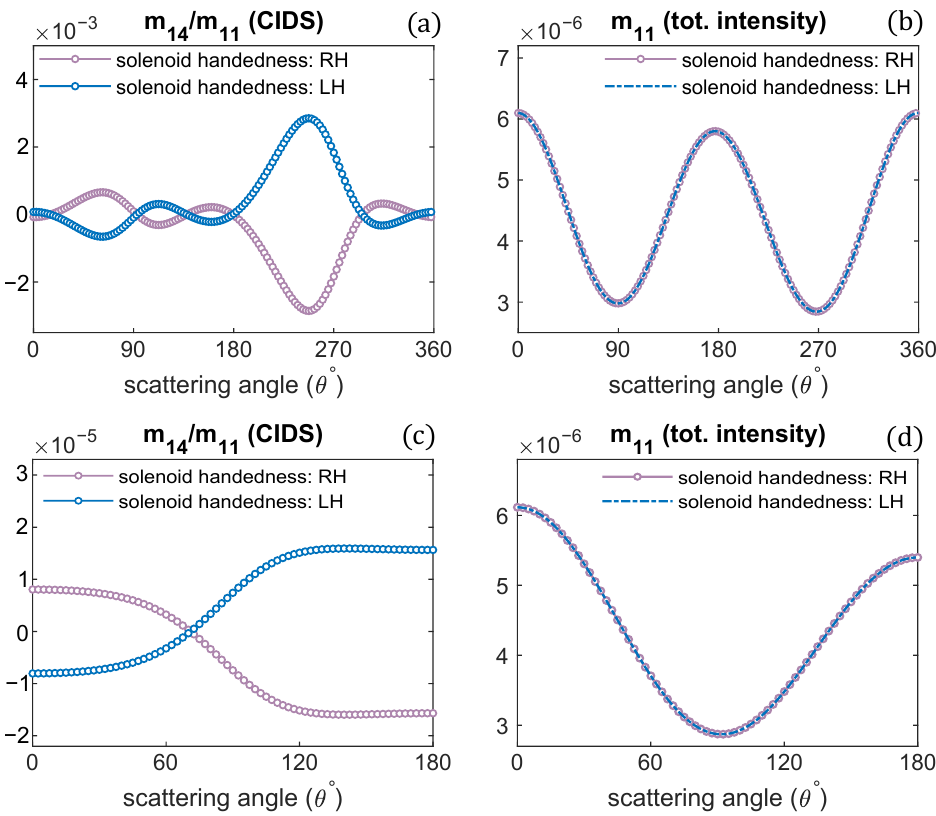
Figure 5. The handedness of solenoid fiber is changed; CIDS and total scattered intensity for oppositely-handed chromatin helical fiber is given: ( a , b ) at a fixed orientation, ( c , d ) in the orientation average. λ = 300